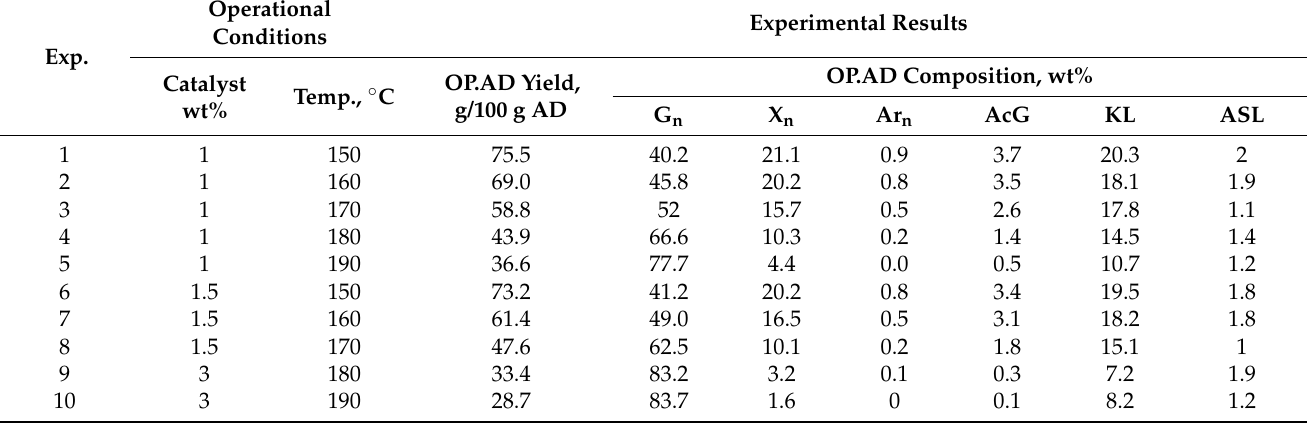
Table 1. Operational conditions considered for AD fractionation and results achieved, operating at